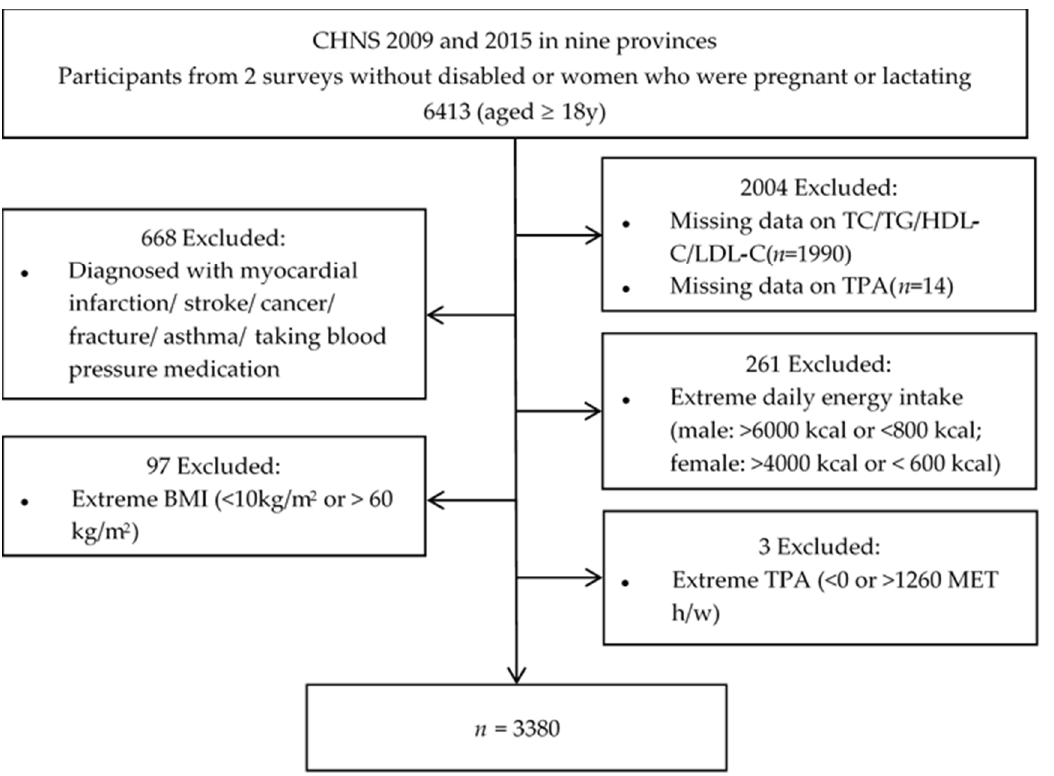
Figure 1. Flow chart of the included study participants from the China Health and Nutrition Survey (CHNS) in 2009 and 2015. TC, total cholesterol; TG, triglycerides; HDL-C, high-density lipoprotein cholesterol; LDL-C, low-density lipoprotein cholesterol; BMI, body mass index; TPA, total physical activity.